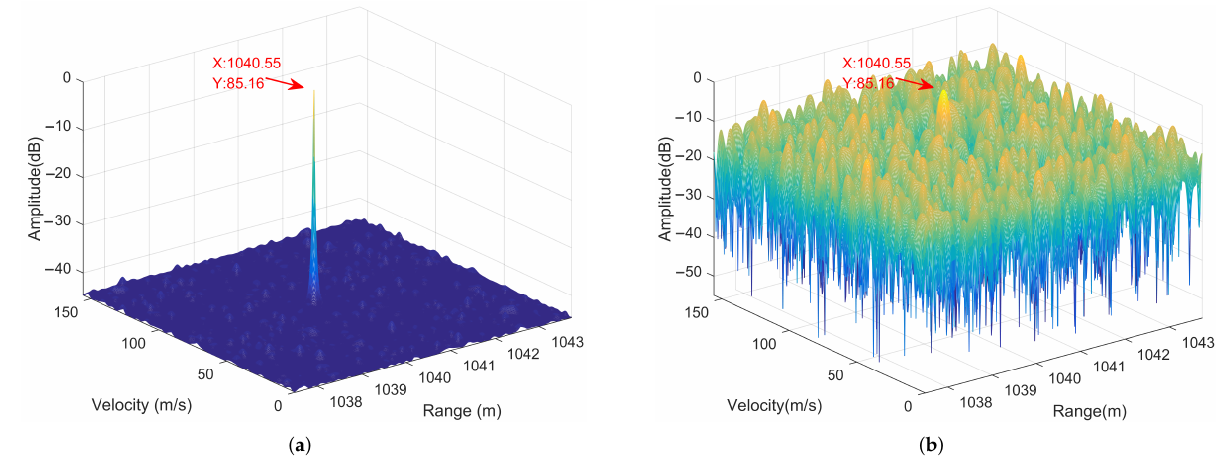
Figure 5. Signal processing results for the moving target. (Target [1040.54 m, 85.2 m/s]). Range– velocity profile using ( a ) MUSIC algorithm ( b ) correlation